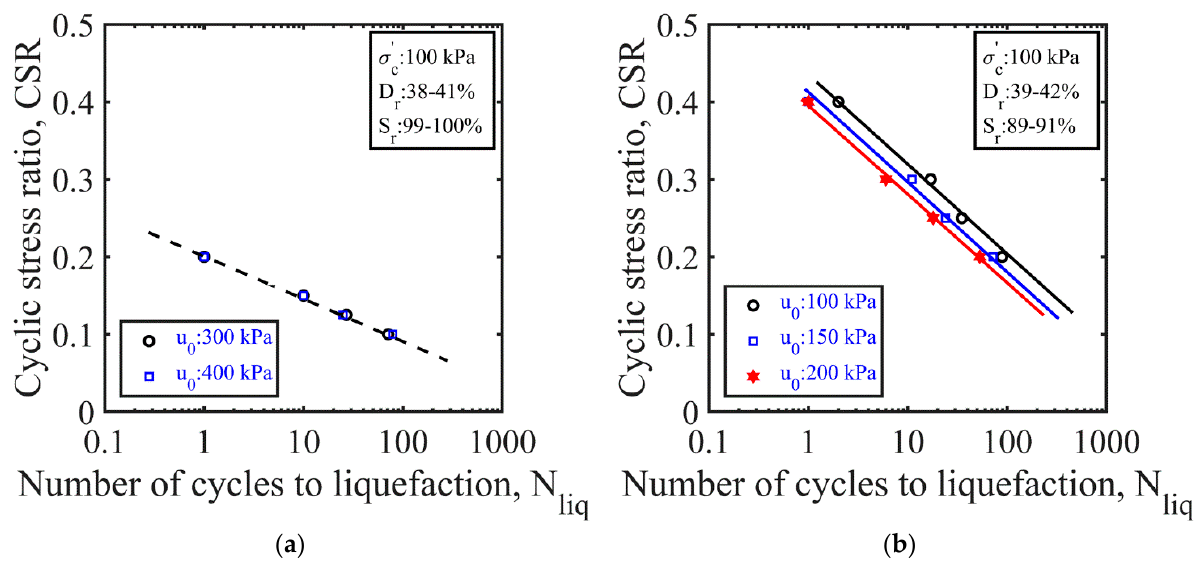
Figure 10. Effect of back pressure on liquefaction resistance of sand: ( a ) nearly/fully saturated sand specimens; ( b ) partially saturated sand specimens.